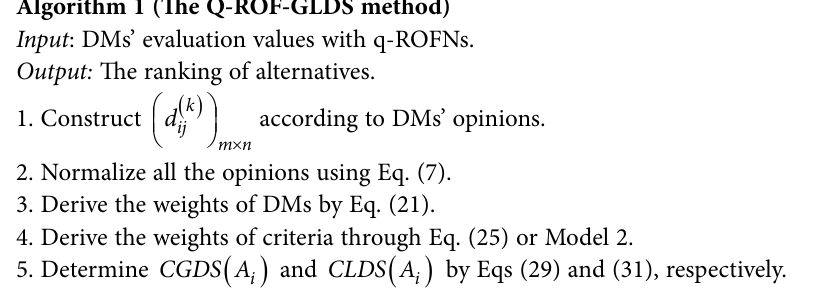
Algorithm 1 (The Q-ROF-GLDS